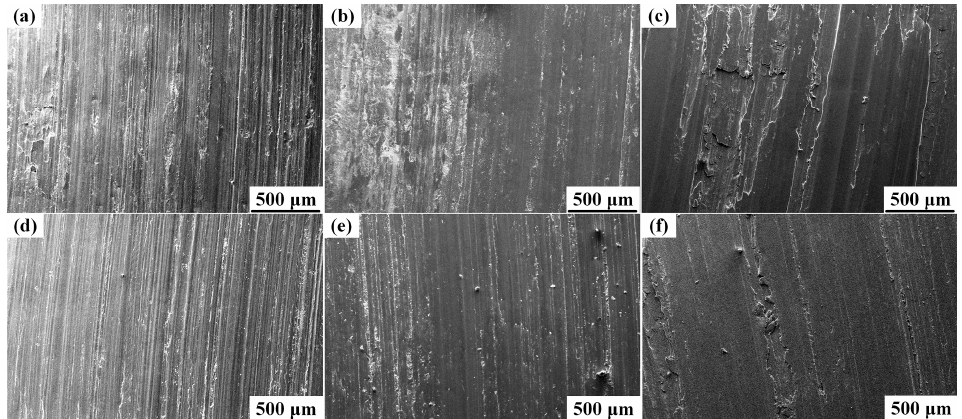
Figure 4. The worn surfaces of the Al-Cu matrix alloy and 0.5 wt.% nano-sized TiC p /Al-Cu composite at different temperatures under 20 N load: the Al-Cu matrix alloy at ( a ) 140 °C, ( b ) 180 °C and ( c ) 220 °C; the nanocomposite at ( d ) 140 °C, ( e ) 180 °C and ( f ) 220 °C.